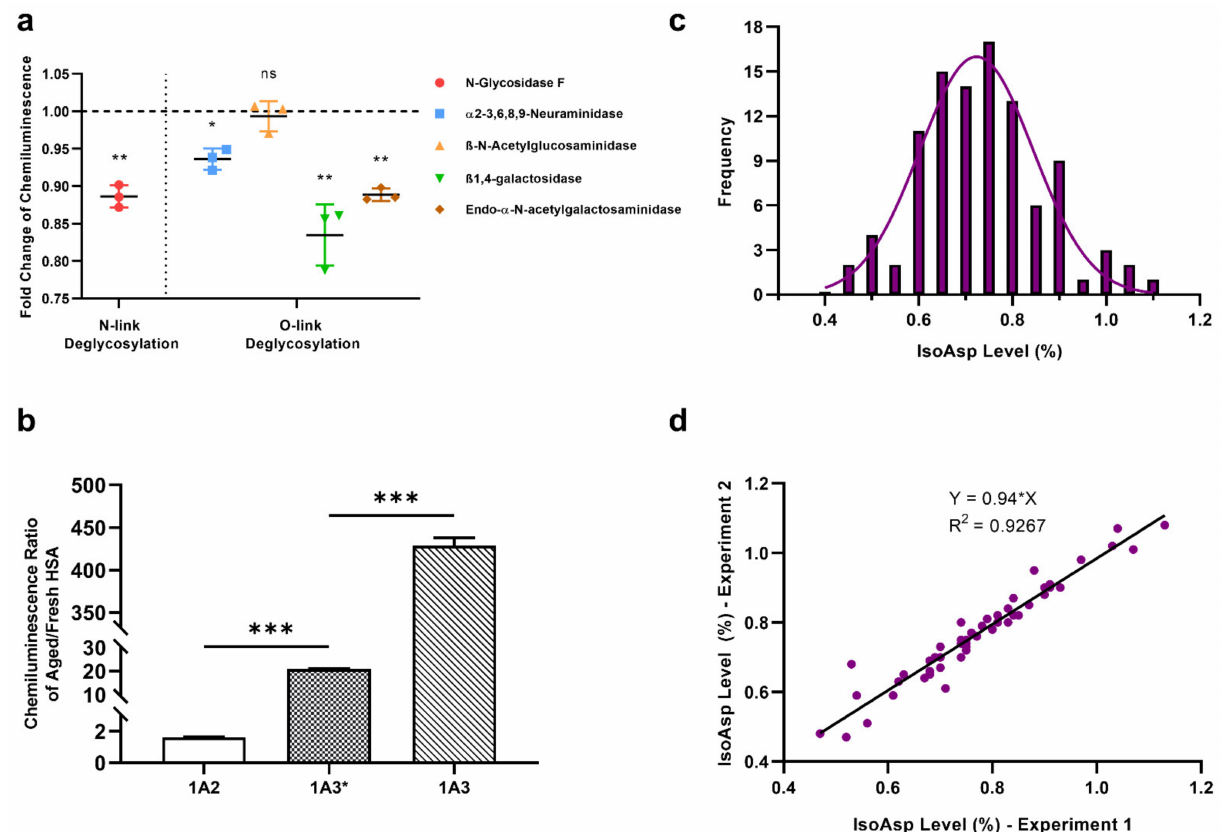
Figure 4. The application of 1A3 mAb in indirect ELISA for determination of isoAsp in blood HSA. ( a ) The changes in 1A3 specificity to aHSA after deglycosylation by five different galactosidases; * p < 0.05; ** p < 0.01; ns: not significant. ( b ) The comparison of mAbs specificity to aHSA versus fHSA for 1A2, 1A3* and 1A3 mAb, where 1A3* has the same variable region sequences as 1A3 but of a different IgG isotype (IgG2b compared to IgG3); *** p < 0.0001 ( c ) The distribution of isoAsp occupancies in HSA measured in 100 blood plasma samples from healthy individuals, obtained using linear calibration. ( d ) Comparison between the ELISA results of 50 blood plasma samples measured using 1A3 antibody with a two-week